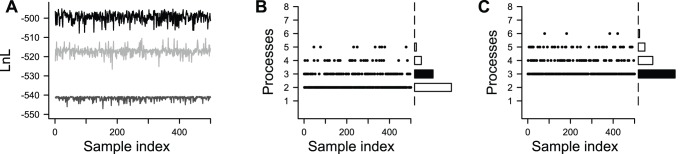
BAMM analysis of example tree (Figure 1).Example tree was simulated under three distinct processes (one constant rate and two diversity dependent processes; two transitions in total). The tree was analyzed under (i) the full multi-process BAMM model with time-variable speciation; (ii) a constrained multi-process BAMM with time-constant speciation; and (iii) a fully constrained 1-process constant-rate birth-death model. (A) Log-likelihoods for thinned MCMC chains for the constant rate birth-death process (bottom), the time-constant multi-process model (middle), and the full BAMM model with time-varying speciation (top). (B) Numbers of transitions during rjMCMC sampling when model is constrained to time-constant speciation rates; sidebar gives frequency distribution of sampled states. (C) Numbers of transitions under full BAMM model with time-variable speciation processes. Black sidebar denotes true number of transitions in generating model. The true number of transitions was estimated correctly only when the assumption of time-constant rates was relaxed.